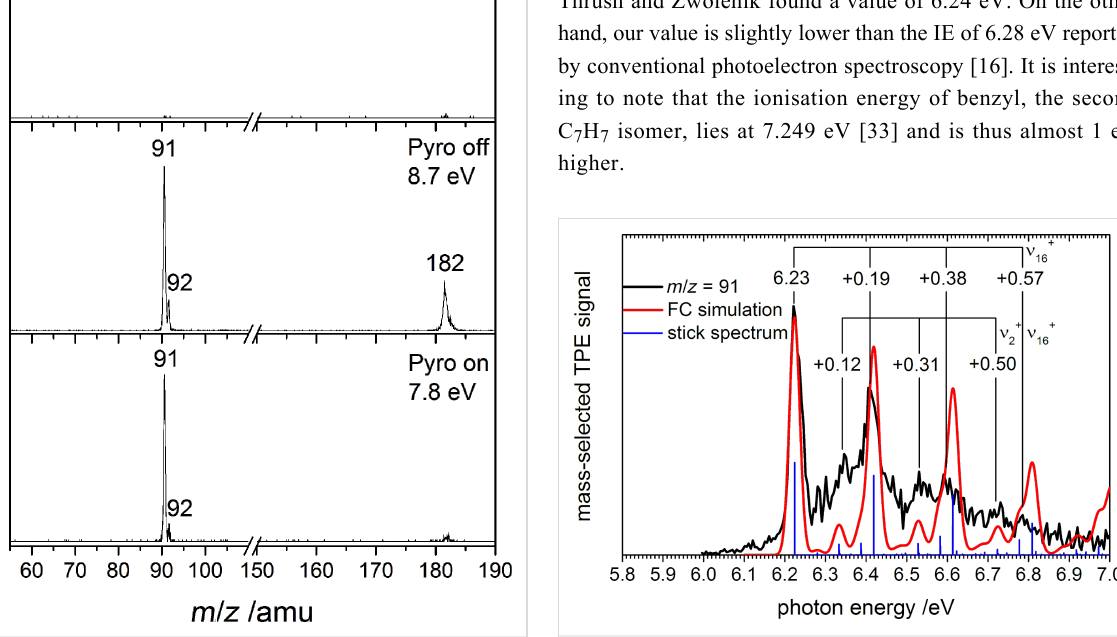
Figure 2: Mass spectra of bitropyl without pyrolysis at 7.8 and 8.7 eV (top and centre trace) and with pyrolysis, recorded at 7.8 eV (bottom trace).